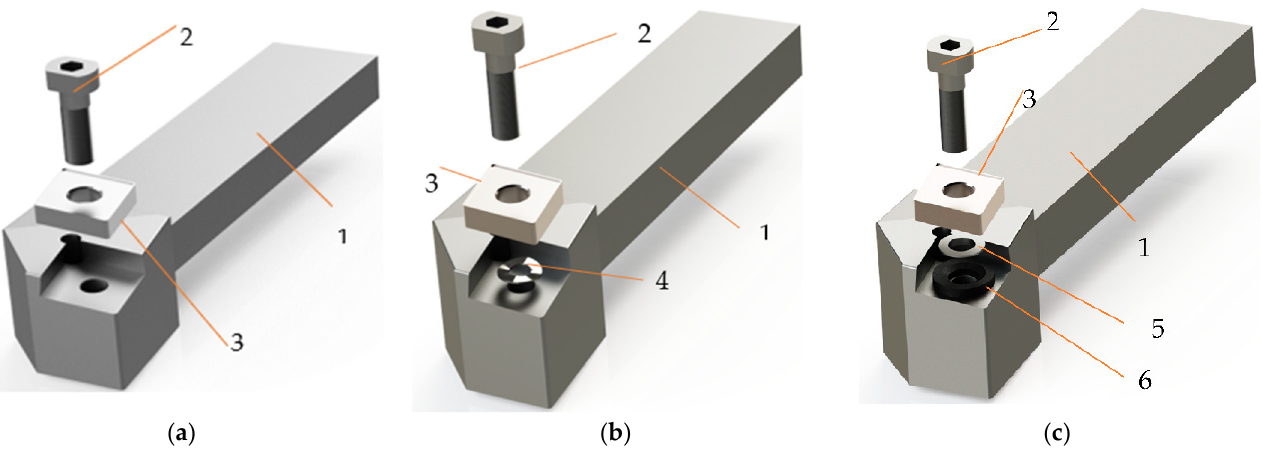
Figure 1. Tools for longitudinal turning: ( a )—in the classic version (V01); ( b )—with improved constructive form with a spring washer (V02), ( c )—with improved constructive form with two spring washers (V03), 1—knife body; 2—screw fixing; 3—removable plate, 4—spring washer, 5—spherical washer, 6—spherical washer holder.